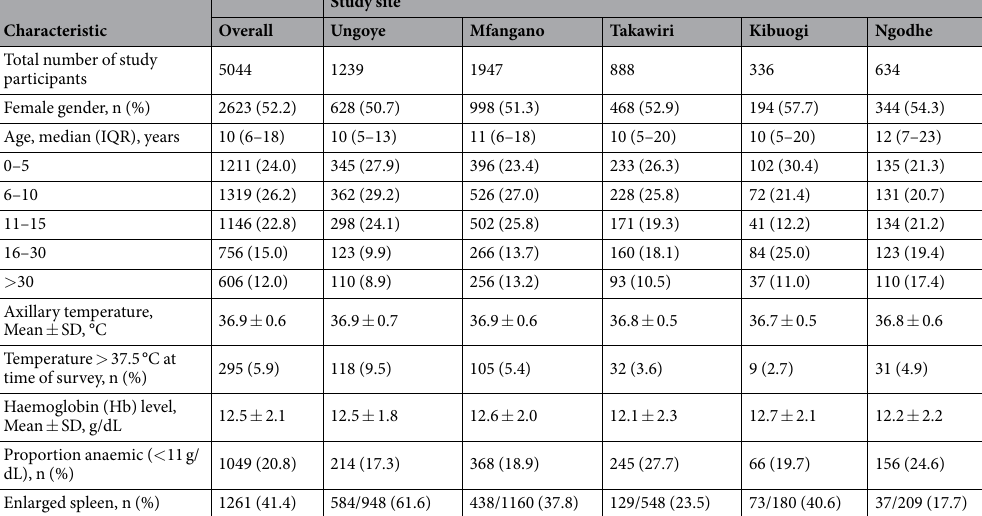
Table 1. Demographic characteristics of all surveyed population. * No gender and age recorded, n = 6; Body temperature, N = 5038; Hb level, N = 5035; Spleen test, N = 3045; IQR, interquartile range, SD; standard